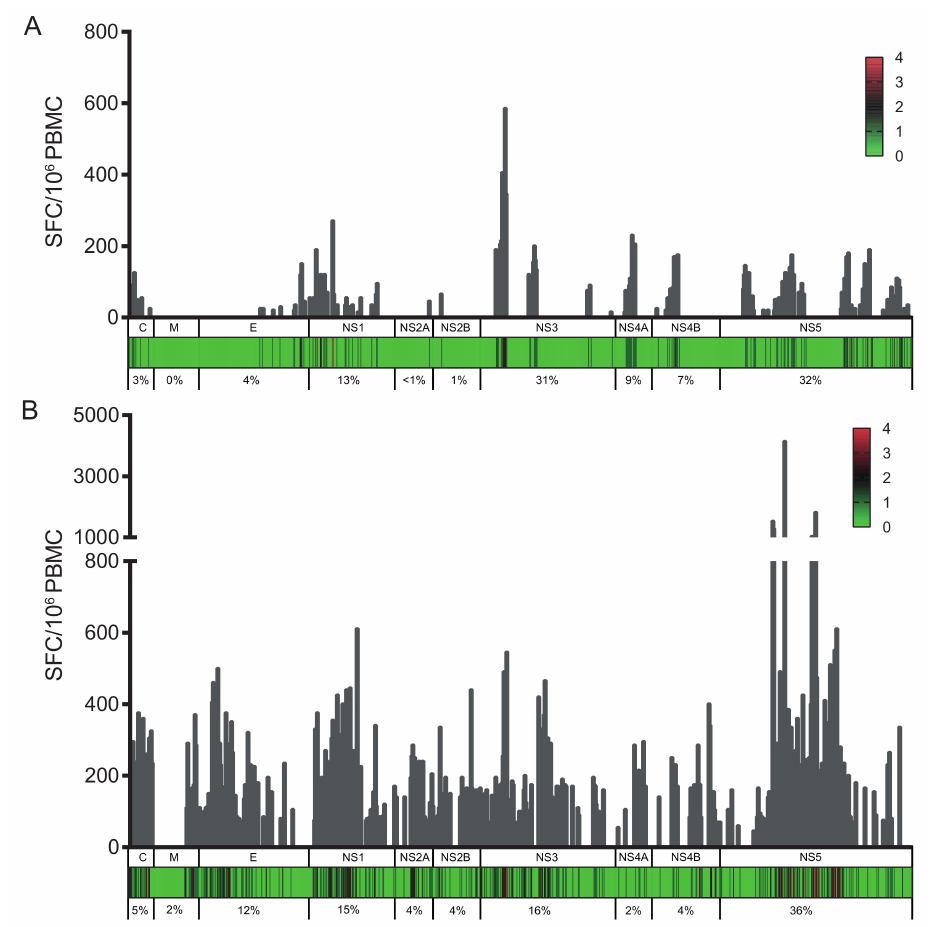
Figure 1. Cumulative IFN- γ responses (as spot-forming cells (SFCs) per million cells) for each overlapping peptide spanning the ZIKV proteome. ( A ) SFCs per million cells are shown for donors from group B; ( B ) SFCs per million cells are shown for donors from groups C, D, and E. The heat map indicates the number of donors with a positive IFN- γ response to each peptide within each protein (C, capsid; M, membrane; E, envelope, NS1, NS2A, NS2B, NS3, NS4A, NS4B, and NS5). The numbers below each graph represent percentages of the total response for each